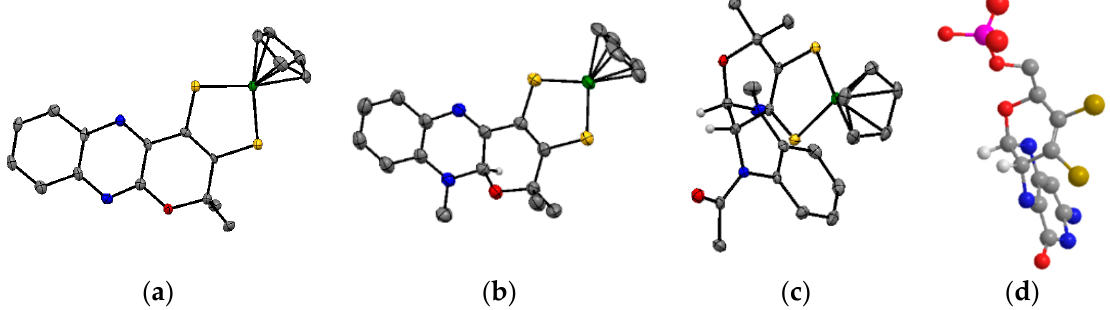
Figure 5. Structure representations of ( a ) [Co III Cp(qpdt)] 19 , ( b ) [Co III Cp(H ‐ qpdt)] 26 , and ( c ) [Co III Cp(2H ‐ qpdt)] 27 and ( d ) Mo IV (MPT) 2 3D ‐ simplified representation of an MPT ligand in FDHs.